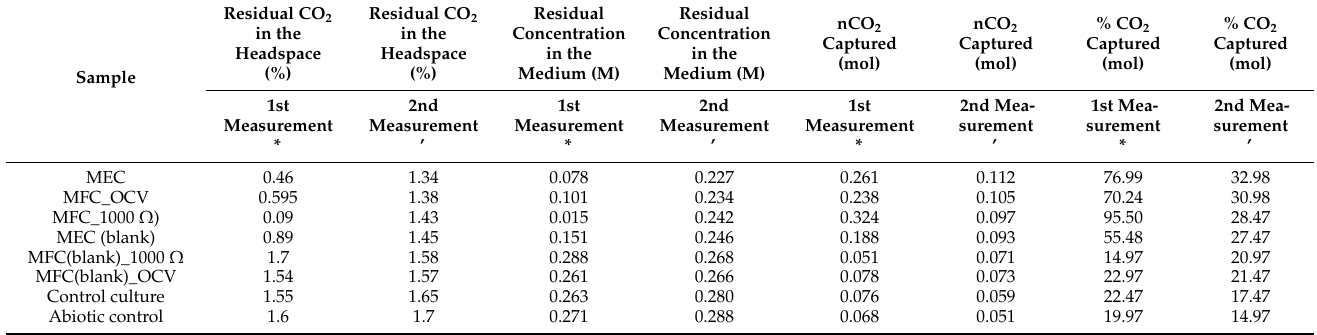
Table 1. CO 2 removal in MFC_+1.5 V: MFCs with 1.5 V applied; MFC_1000 Ω : MFC kept at 1000 Ω